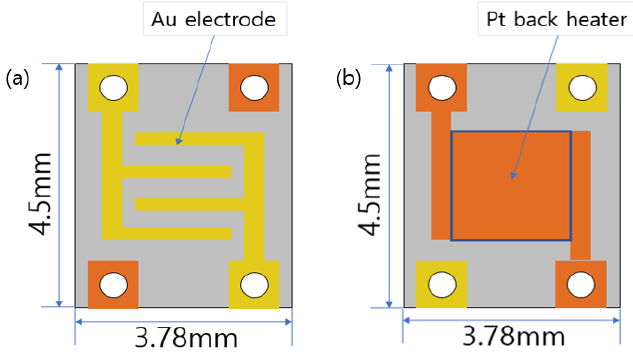
Figure 1. Configuration diagram of the sensor substrate ( a ) front side ( b ) rear side.